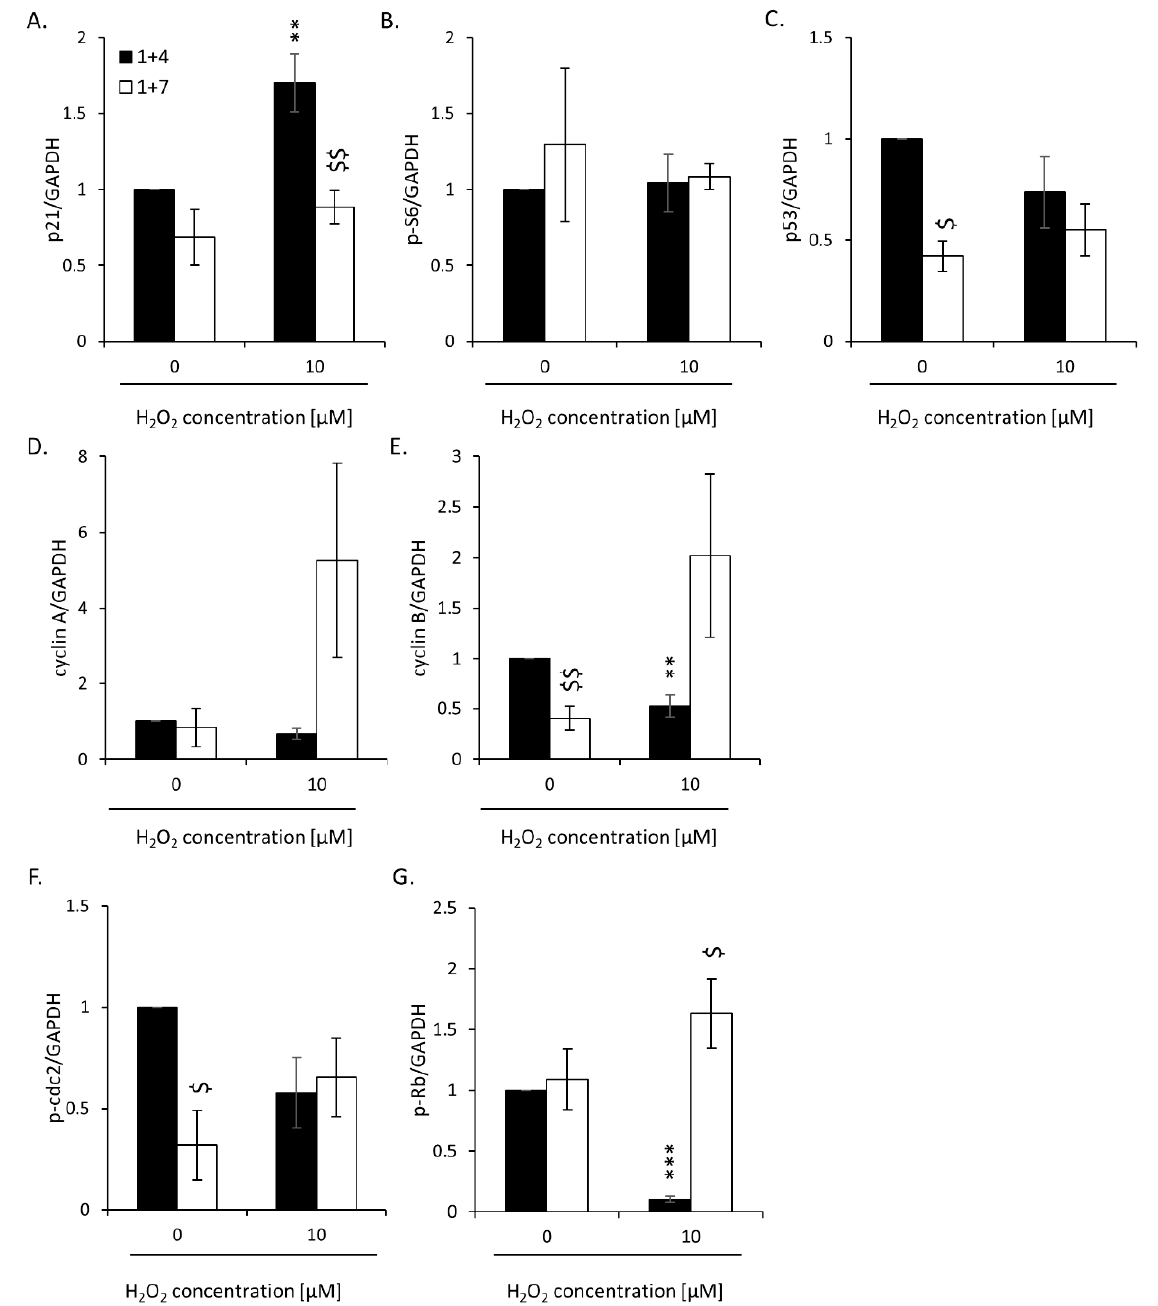
Figure A3. Evaluation of protein expression in HCT116 cells treated with 2.5 µM IRINO subjected to 5 or 10 µM H 2 O 2 after the 4th and 7th days of the experiment: cell cycle inhibition and proliferation markers. Quantification is based on the densitometry analysis performed with the use of ImageJ software. Data are shown as the ratio of the protein amount to respective protein loading control (GAPDH): ( A ) p21; ( B ) p-S6; ( C ) p53; ( D ) cyclin A; ( E ) cyclin B; ( F ) p-cdc2; ( G ) p-Rb. Each bar represents mean ± SEM, n ≥ 3; ** p < 0.01, *** p < 0.001—vs. 1 + 4 control; $ p < 0.05, $$ p < 0.01—1 + 7 vs. 1 + 4.